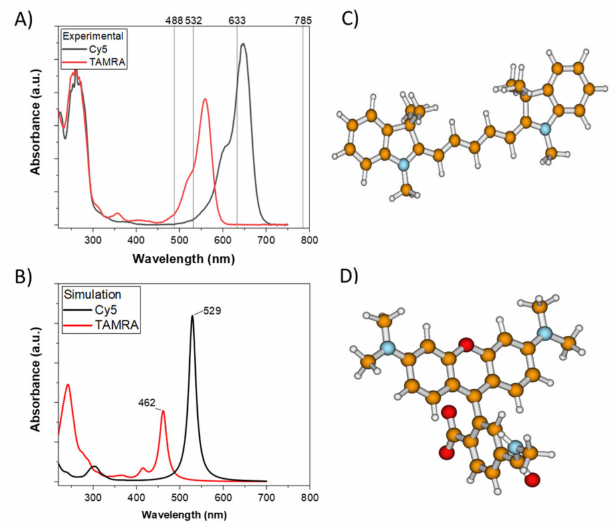
Figure 1. ( A ) UV-Vis spectra of the dyes free in solution, and the respective excitation wavelengths used for Raman analysis. ( B ) Computed UV-Vis spectra obtained from corresponding TD-B3LYP vertical transition energies and oscillator strengths. Geometries obtained for the molecular models used in this work for ( C ) Cy5 and ( D ) TAMRA, optimized at the B3LYP+D3/6-311++G** (+PCM (water)) level of theory (color code: H = white, C = orange, N = blue, O =